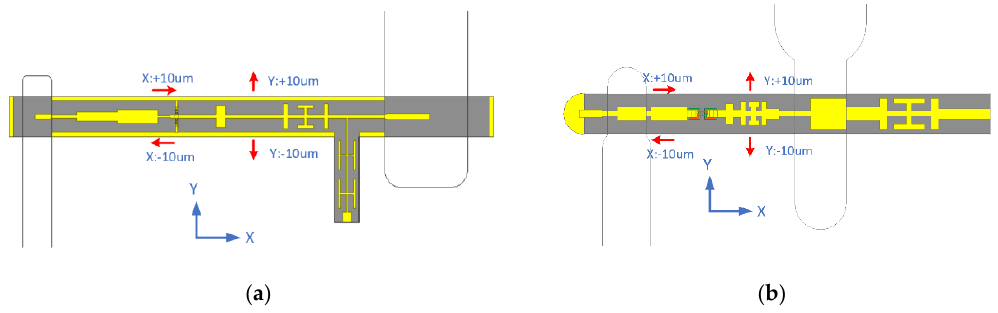
Figure 9. Tolerance analysis of ( a ) 0.34 THz tripler and ( b ) 0.34 THz SHM caused by a substrate assembly error. The substrate assembly position deviates from the original position ±10 μ m along the x and y directions, respectively.